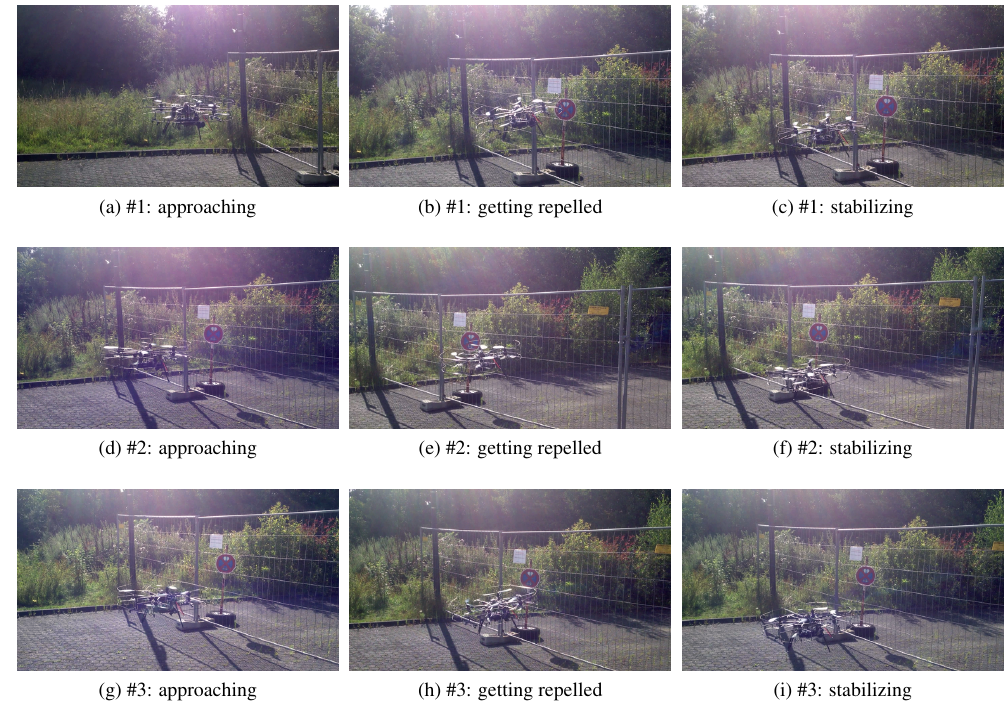
Figure 11: Photos taken during three experiments. Videos are available at: